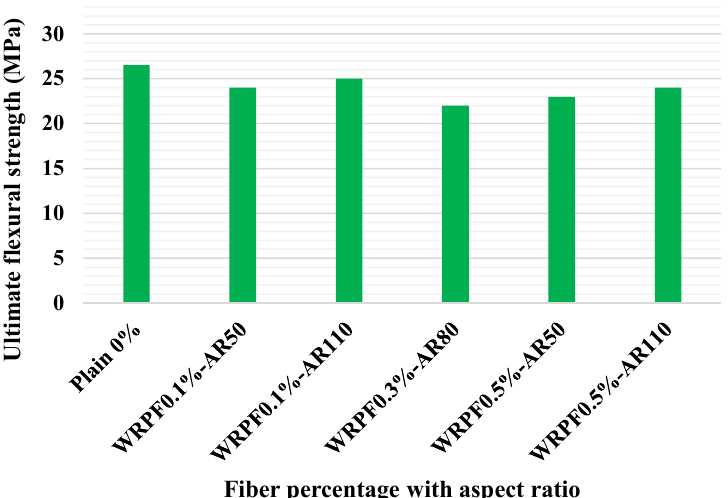
Figure 9. Ultimate FS of the control samples and Waste recycled plastic fiber (WRPFs) concretes with various fiber aspect ratios [75]. Waste recycled plastic fiber (WRPF); aspect ratio